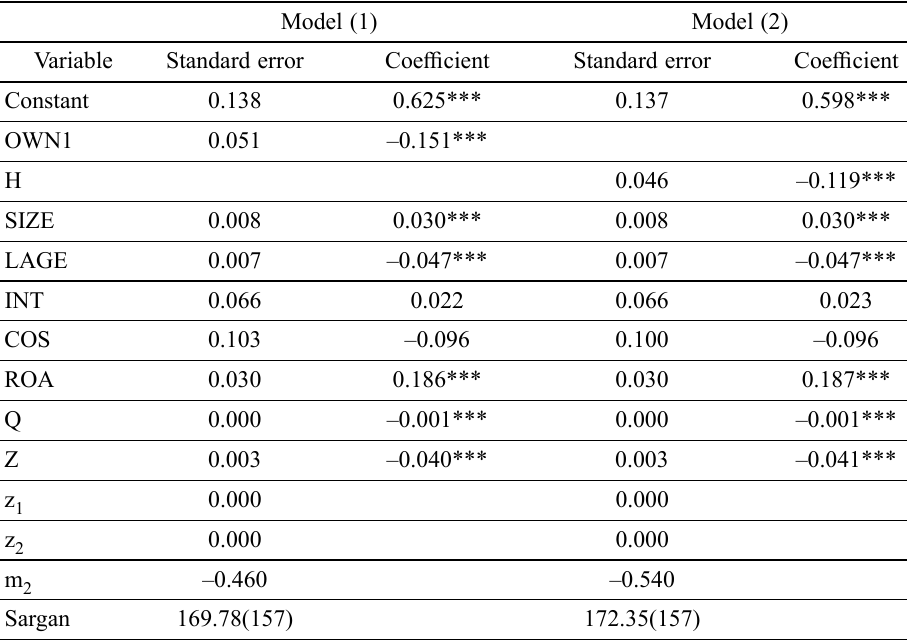
Table 2. GMM Panel Data Regression relative to the influence of ownership